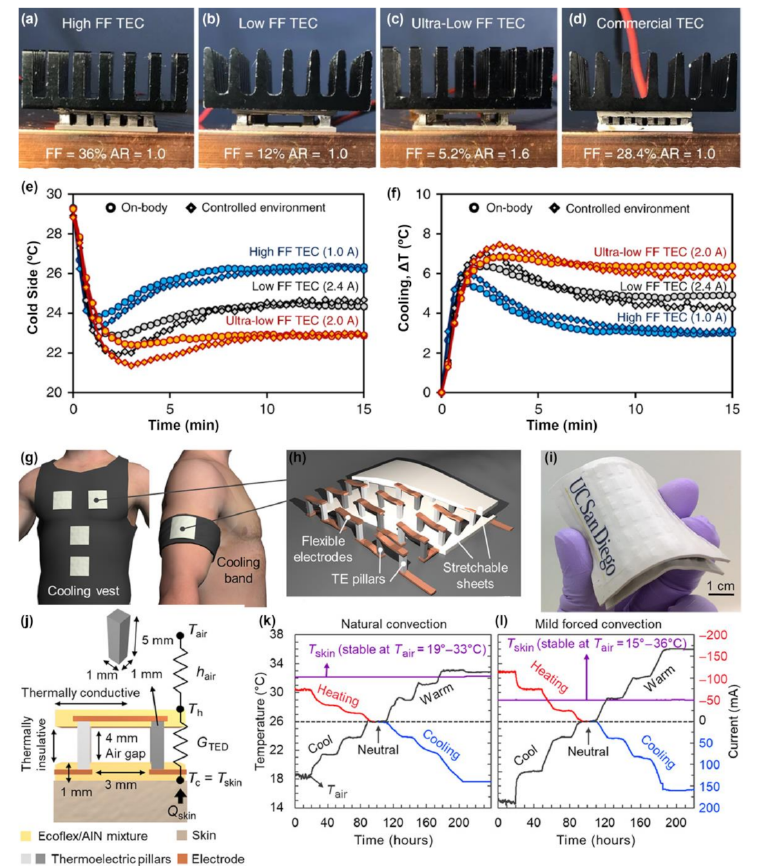
Figure 4. Wearable TEC for localized cooling [5]. ( a – d ) TEC modules fabricated with commercial p- and n-type Bi-Te with ( a ) high fill factor (FF) (FF = 36%, aspect ratio, AR = 1.0), ( b ) low FF (FF = 12%, AR = 1.0), ( c ) ultra-low FF (FF = 5.2%, AR = 1.6), and ( d ) commercial TEC module (FF = 28.4%, AR = 1.0). The black heat sink is anodized aluminum. ( e , f ) Show transient temperature data from cooling the human body and in controlled environments, for the various TECs. The optimal currents are 1 A for high FF TEC (blue), 2.4 A for low FF TEC (black), and 2 A for ultra-low FF TEC (red). Ultra- low FF TEC generates the lowest cold side temperature and has the highest cooling. Reproduced